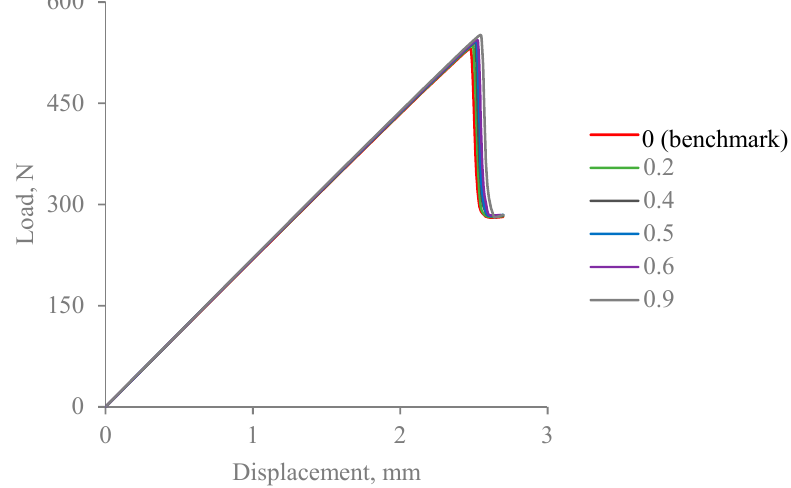
Figure 19. Load ‐ displacement curves in Mode II simulations at a range of friction values. Figure 19. Load-displacement curves in Mode II simulations at a range of friction